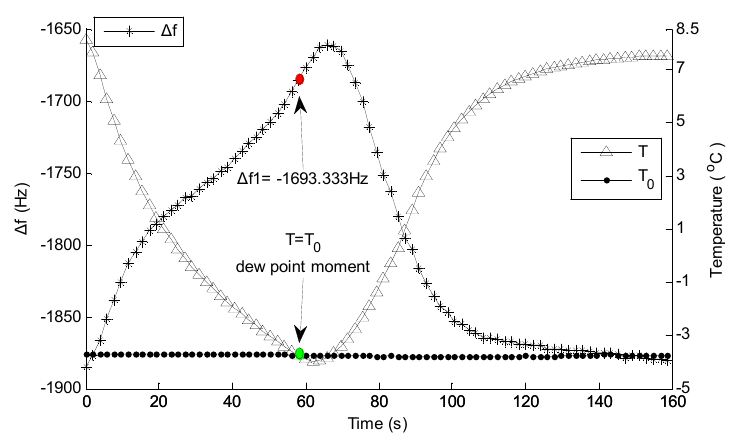
Figure 8. Variation regularity of ∆ f in a temperature-control circle.